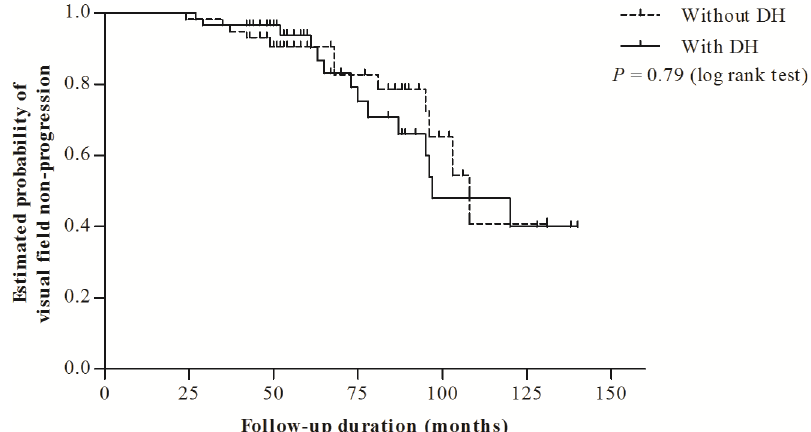
Fig 2. Kaplan–Meier analysis of probability of maintained non-deterioration of visual field (VF) in patients with disc hemorrhage (DH) and in those without DH. The cumulative probabilityof non- progression of VF (10-year survival rate: 0.40 ± 0.12) was statistically equivalent betweenthe DH and non-DH groups(10-year survival rate: 0.41 ± 0.15) (P = 0.79, log rank test).